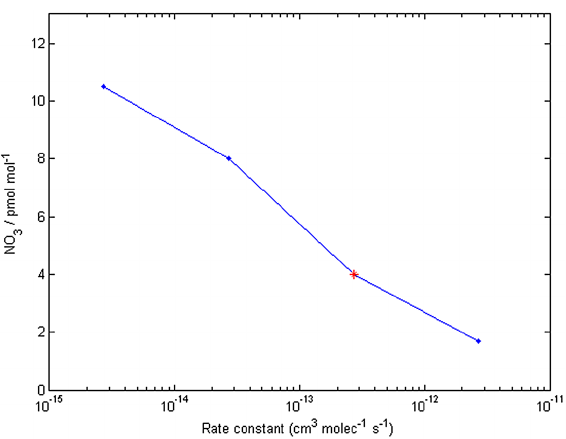
Figure 6. Sensitivity run showing the effect of the uncertainty in the rate constant estimation on the reduction of NO 3 peak night- time concentration at the surface – the red point is the theoretical estimate.